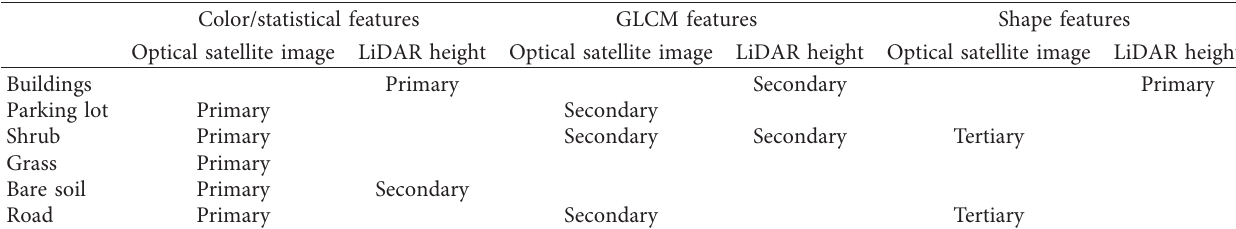
Table 5: Priority of low-level features defined from the second experimental datasets. Color/statistical features